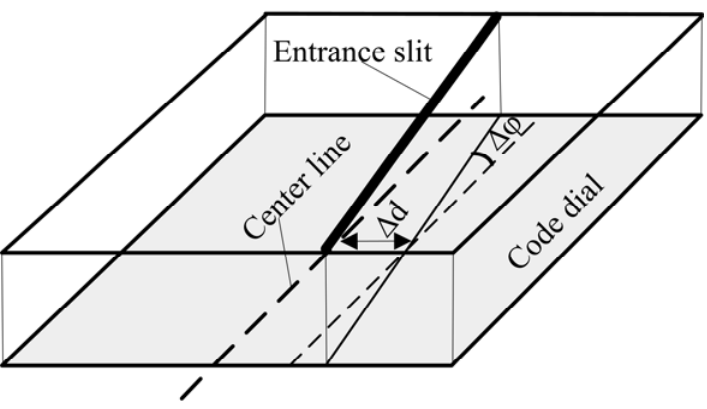
Figure 4. Misalignment between entrance slit and code dial.